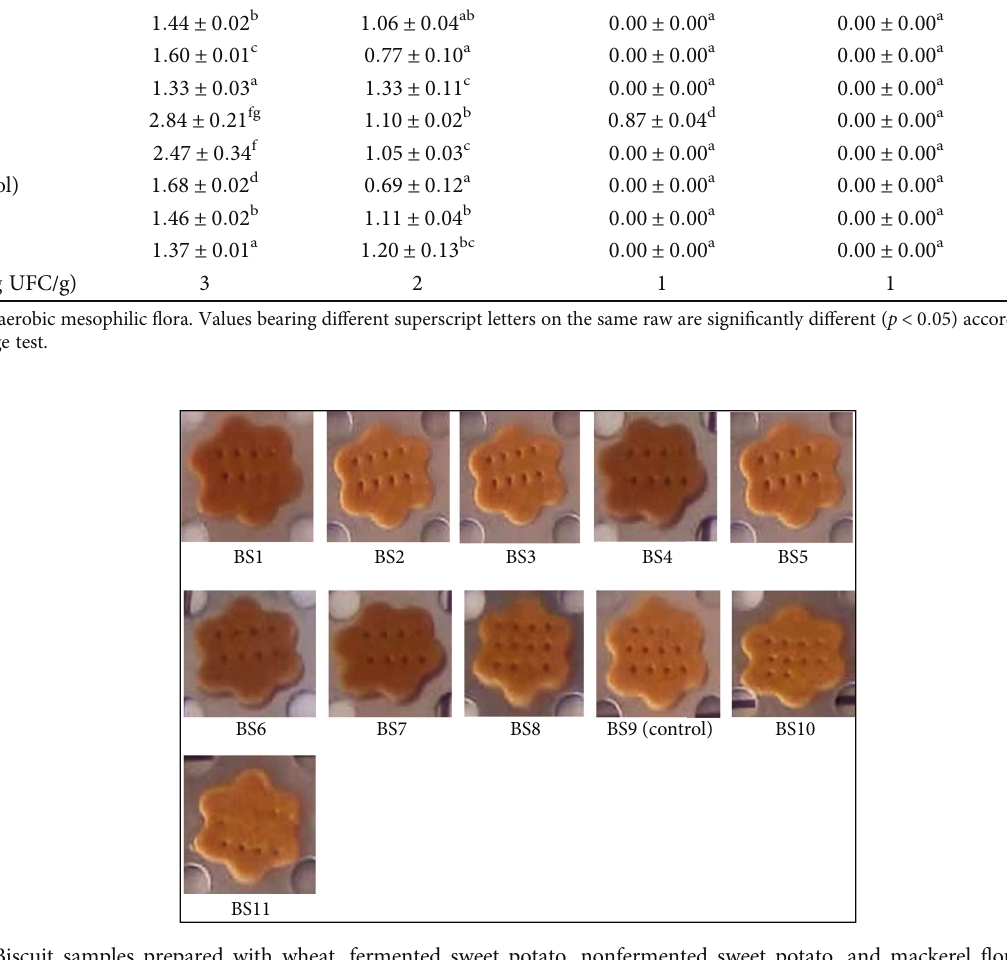
Figure 1: Biscuit samples prepared with wheat, fermented sweet potato, nonfermented sweet potato, and mackerel fl ours at di ff erent proportions. Table 5: Sensory characteristics of the biscuits prepared with di ff erent proportions of fl our from fermented sweet potato. Biscuit